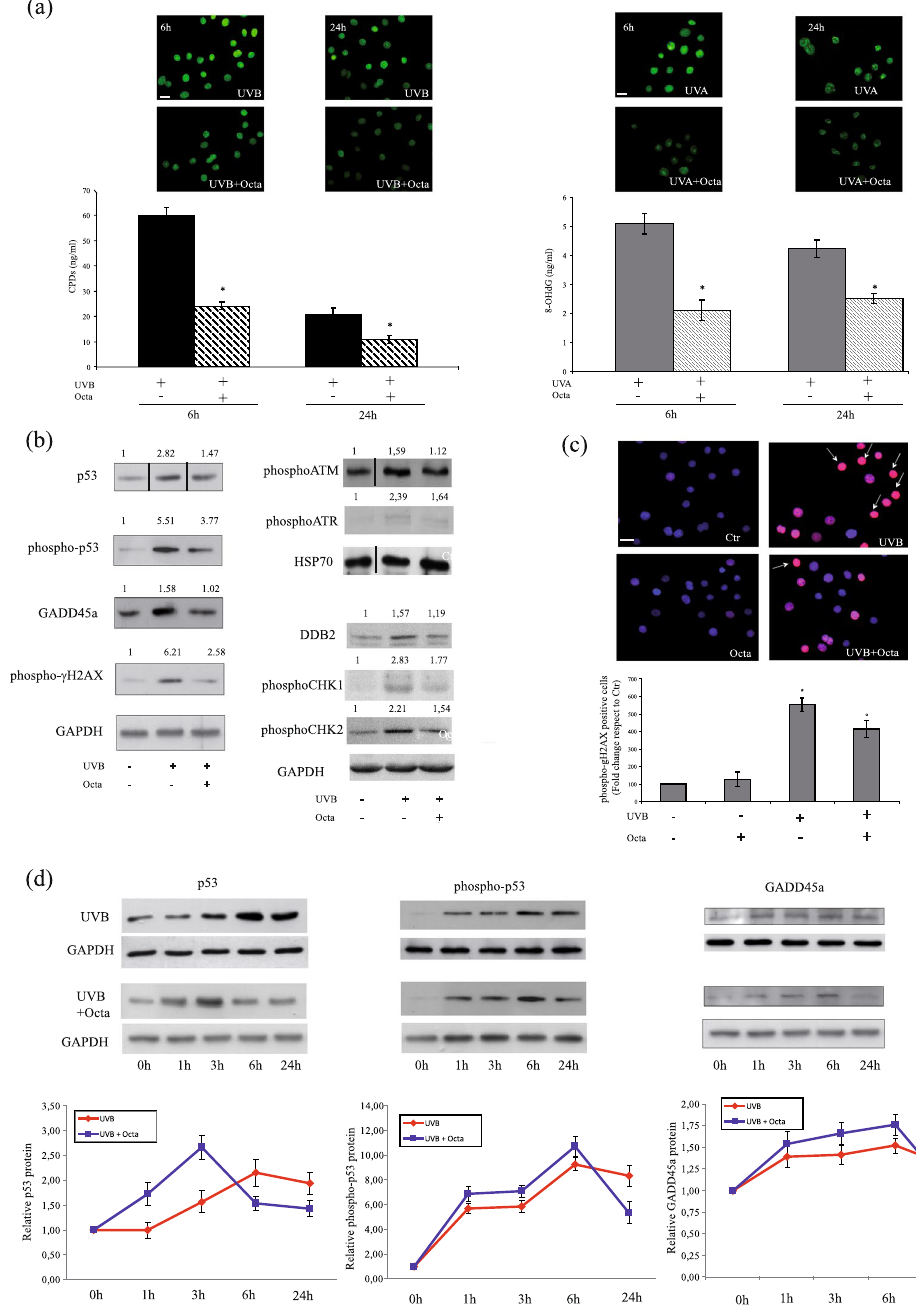
Figure 4. Effect of Octa post-treatment on UVB-induced DNA damage. ( a ) Immunofluorescence analysis of CPDs and 8-oxodG (green signal) in NHKs irradiated with UVB 25 mJ/cm2 or UVA 10 J/cm2 and post- treated with 90 µ M Octa for 6 h and 24 h. Scale bar: 20 µ m. ELISA analysis of the amount of CPDs and 8-oxodG remaining in NHKs irradiated with UVB 25 mJ/cm2 or UVA 10 J/cm2 and post-treated with 90 µ M Octa for 6 and 24 h. The values reported represent means ± SD of three independent experiments performed in duplicate. * p < 0,001 (vs UVB-irradiated cells), * p < 0,005 (vs UVA-irradiated cells). ( b ) Western blot analysis of p53, phospho-p53, GADD45a, phospho- γ H2AX, phosho-ATM, phospho-ATR, DDB-2, phospho-Chk1 and phosphor-Chk2 protein expression on cell lysate of NHKs irradiated with UVB 25 mJ/cm2 and post- treated with 90 µ M Octa for 24 h. GAPDH and HSP70 were used as a loading control. Results refer to three independent experiments. Representative blots are shown. Densitometric scanning of band intensities was performed to quantify the change of protein expression (control value taken as one fold in each case). ( c ) Immunofluorescence analysis of phosphorylated histone H2AX expression (red signal) in NHKs irradiated with UVB 25 mJ/cm2 and post-treated with 90 µ M Octa for 24 h. Arrows indicate super-bright positive cells which results reduced in Octa post-treated cells respect to UVB irradiated cells. Quantitative analysis of the phosphorylated histone H2AX fluorescence signal evaluated by counting the number of positive cells/total